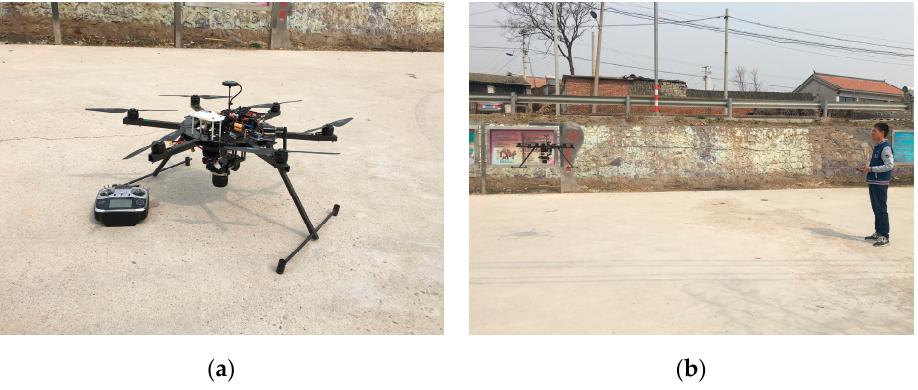
Figure 3. Photographs of ( a ) the DJI S900 UAV equipped with Sony A7r camera and ( b ) the UAV taking off.